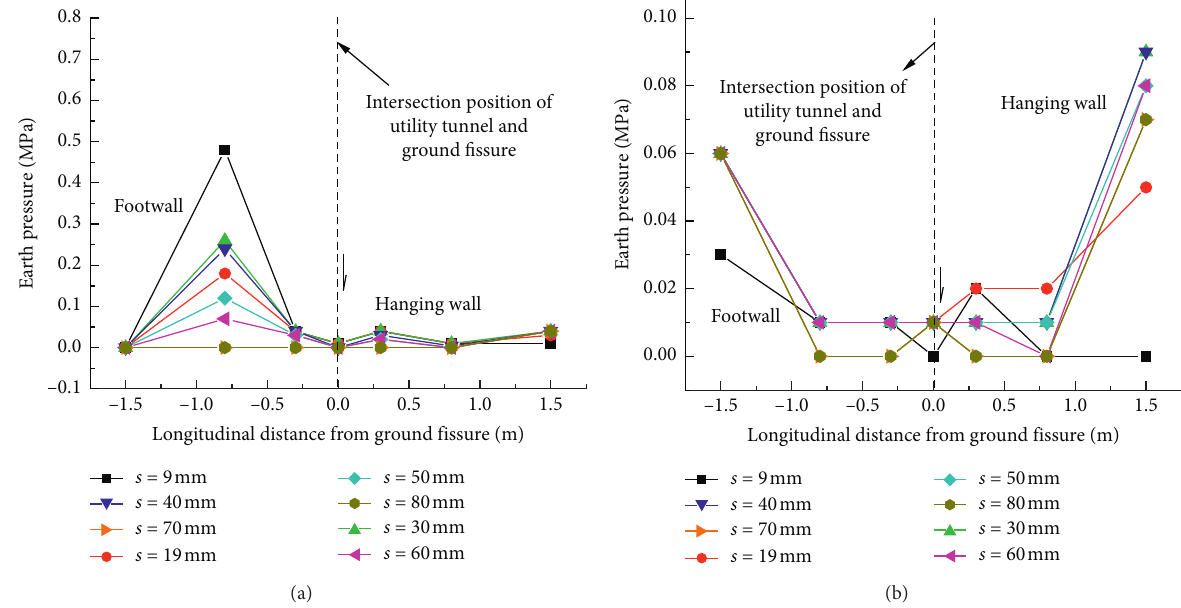
Figure 10: Longitudinal earth pressure curve on top and bottom of structure. (a) Longitudinal earth pressure curve on bottom of structure. (b) Longitudinal earth pressure curve on top of structure.